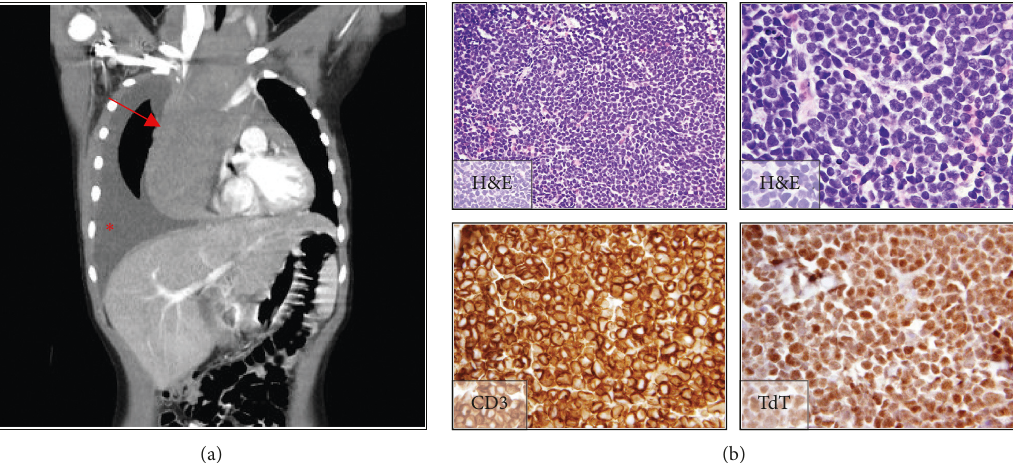
Figure 2: Imaging of mediastinal mass and pathology of lymph node biopsy sample. (a) Coronal view of CTscan of the chest, abdomen, and pelvis demonstrating right anterior mediastinal mass (arrow) measuring 9 (b) Representative images showing sheets of large overtly malignant cells with blastic chromatin. Immunohistochemistry was strongly positive for CD3 and terminal deoxynucleotidyl transferase (TdT).